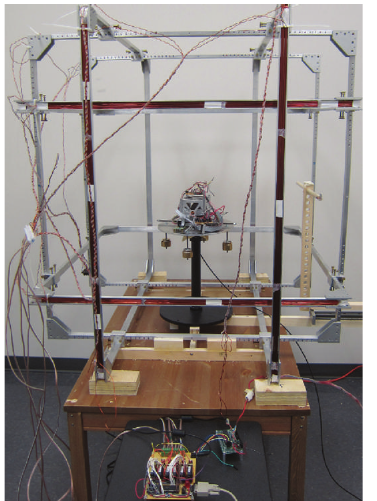
Figure 18: Helmholtz cage for magnetic field